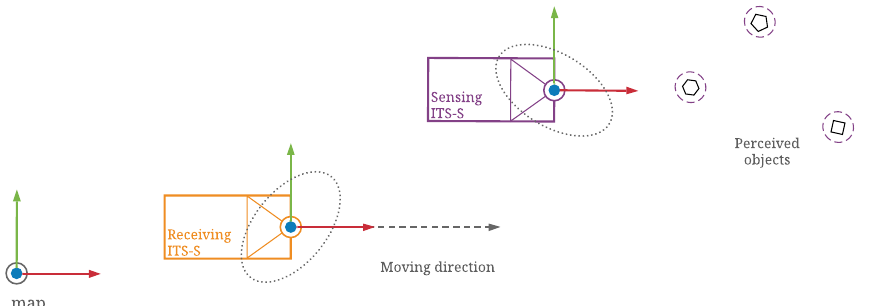
Figure 9. Setup of the sensing and receiving ITS-Ss in the simulation.